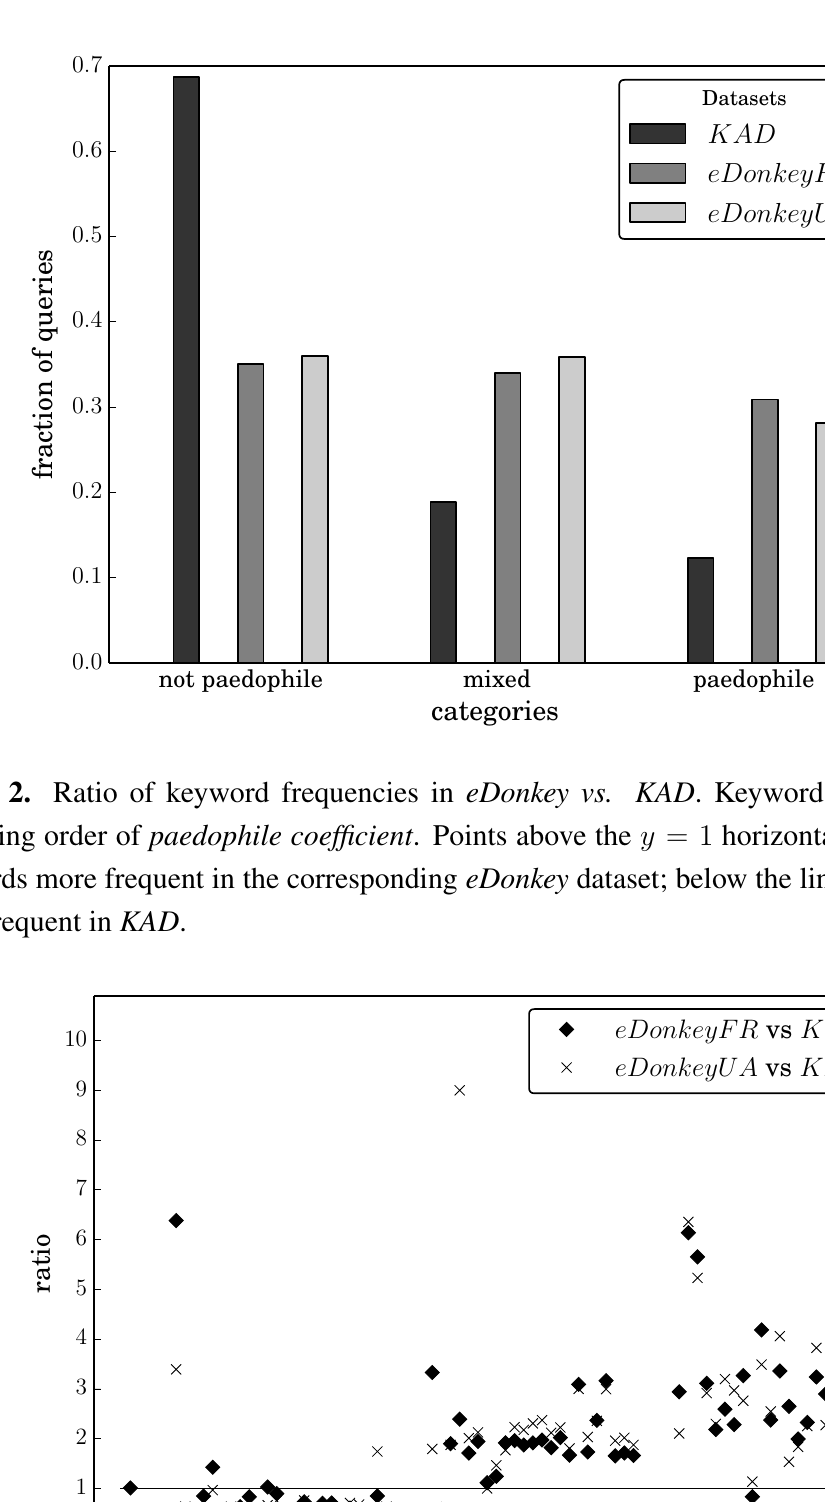
Figure 1. Fraction of queries of each kind in our three datasets.